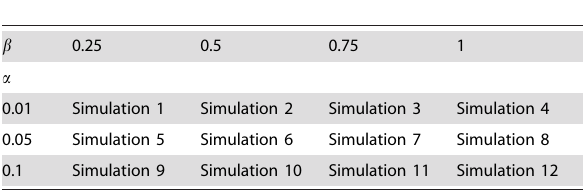
Table 1. CheZ localisation parameters for the simulations.